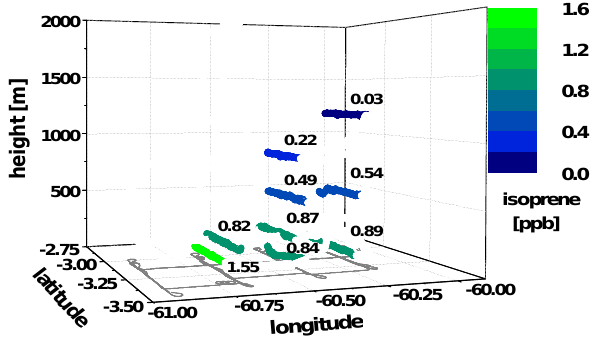
Fig. 10. 3-D image of isoprene mixing ratios observed downwind of Manaus City ( − 3.08 ◦ , − 60.01 ◦ ) during Flight #18 on 19 July 2001, 10:00–14:00LT. One longitudinal degree corresponds to ∼